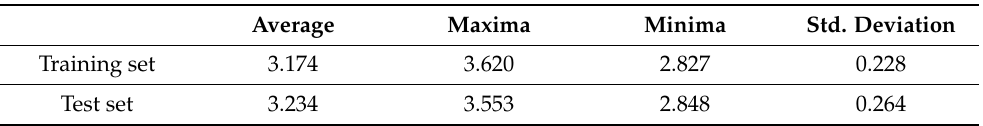
Table 2. Unicolumn statistical data of training and test set in 2D quantitative structure–activity relationship (QSAR) models.